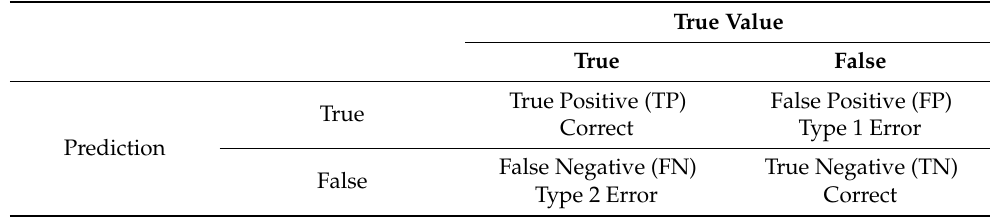
Table 1. Confusion Table 1. Confusion matrix. Table 1. Confusion matrix.